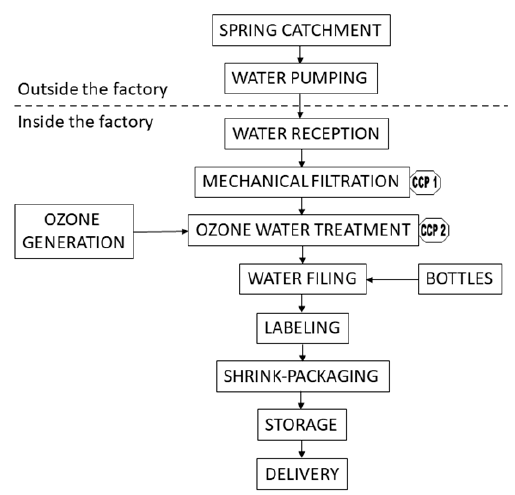
Figure 2. Process flow diagram of water production and bottling.